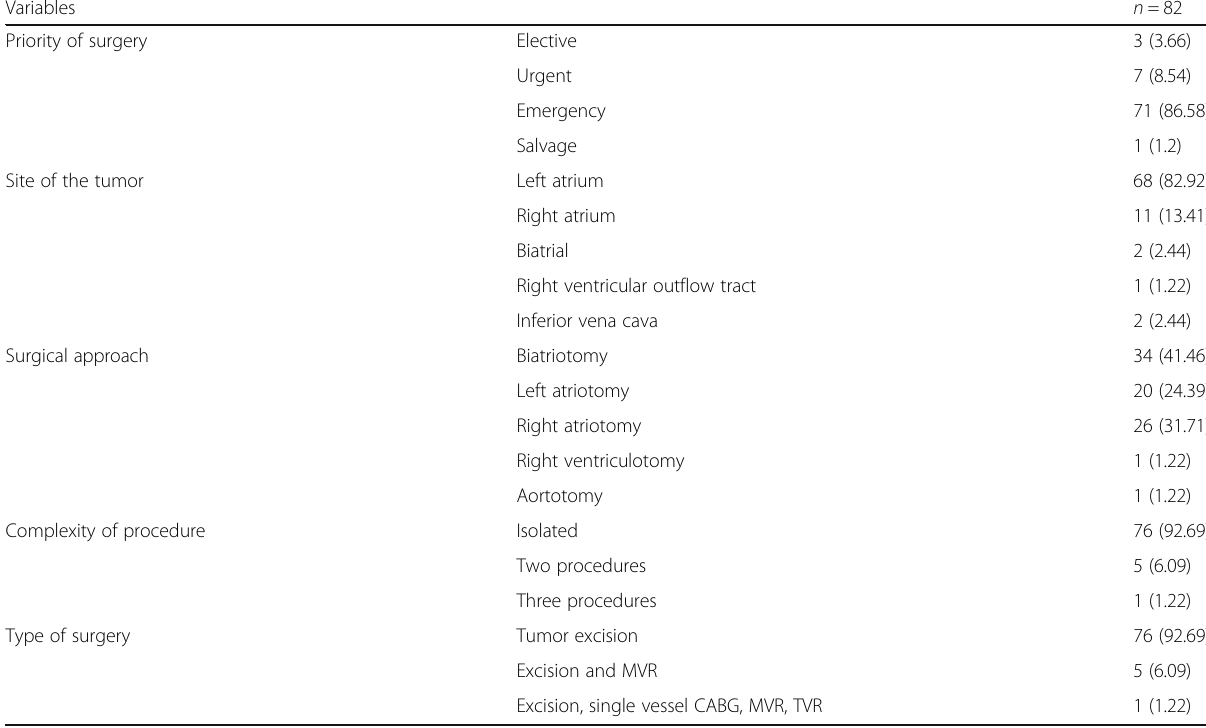
Table 2 Intraoperative characteristics of the study patients Variables Priority of surgery